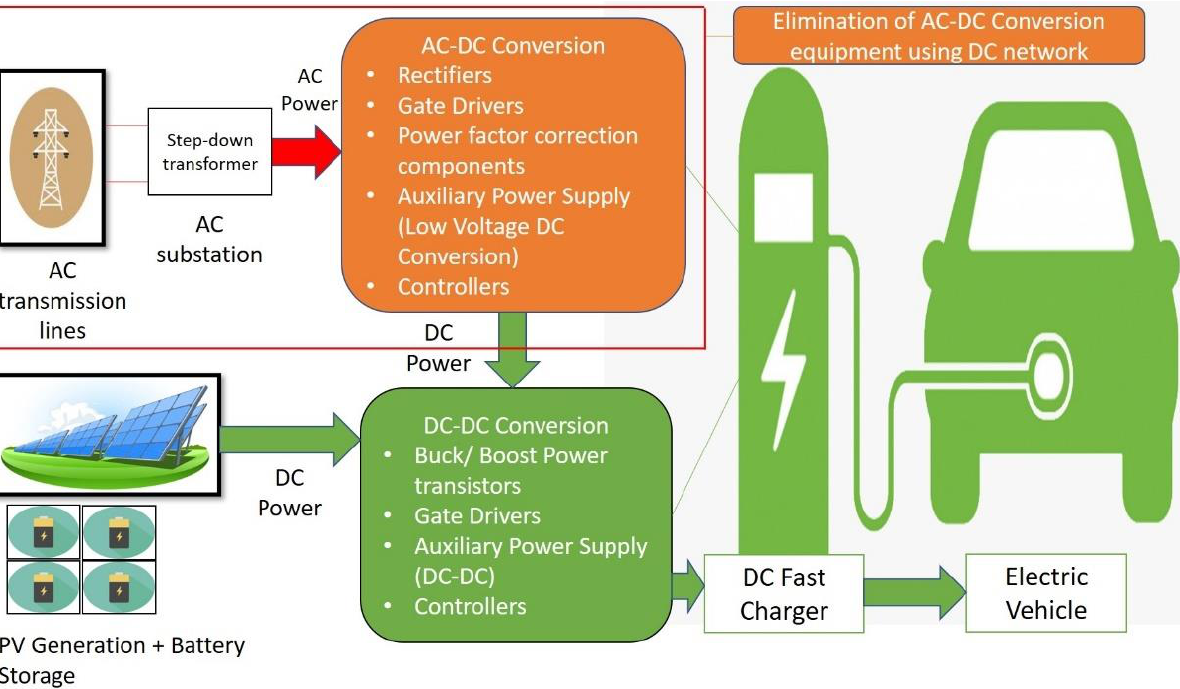
Figure 3. Functional block diagram of a DC Fast Charger.